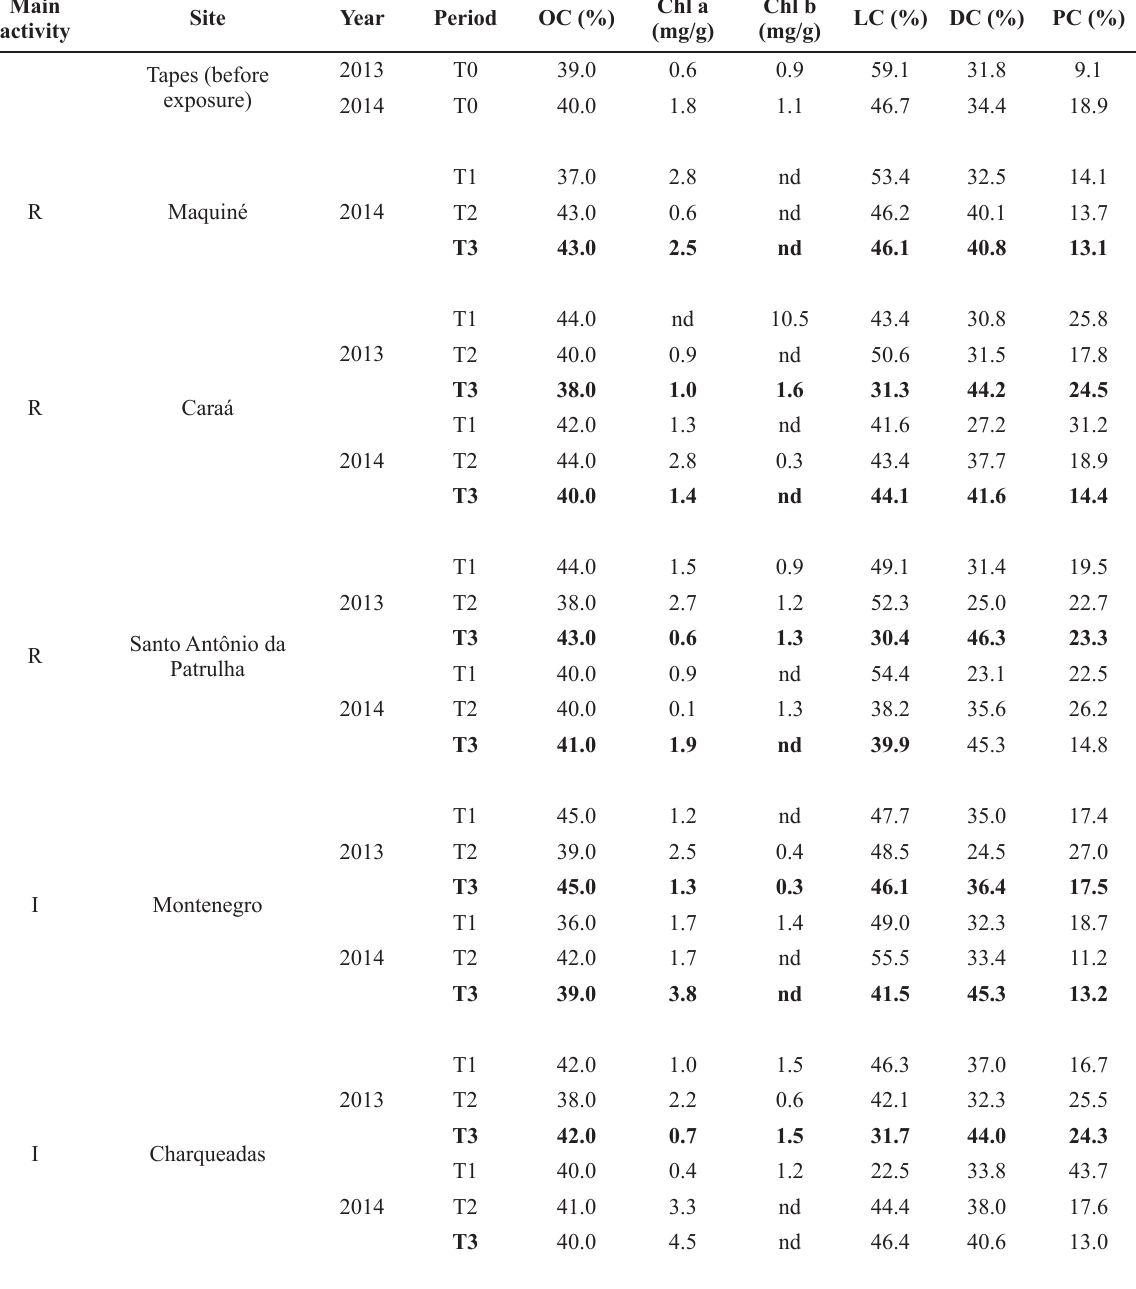
Lichen physiological parameters measured to evaluate the damages on the photobiont (Chl a , Chl b and percentage of live, plasmolysed and dead cells) and on the mycobiont (percentage of organic carbon) after exposure. Thalli of Parmotrema tinctorum were exposed during seven months in 2013 and 2014